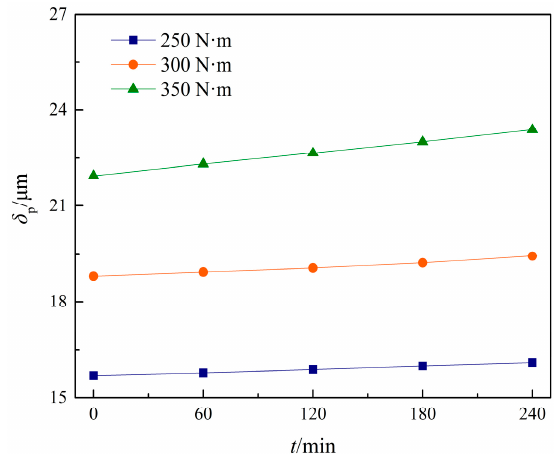
Figure 18. δ p at different torques.